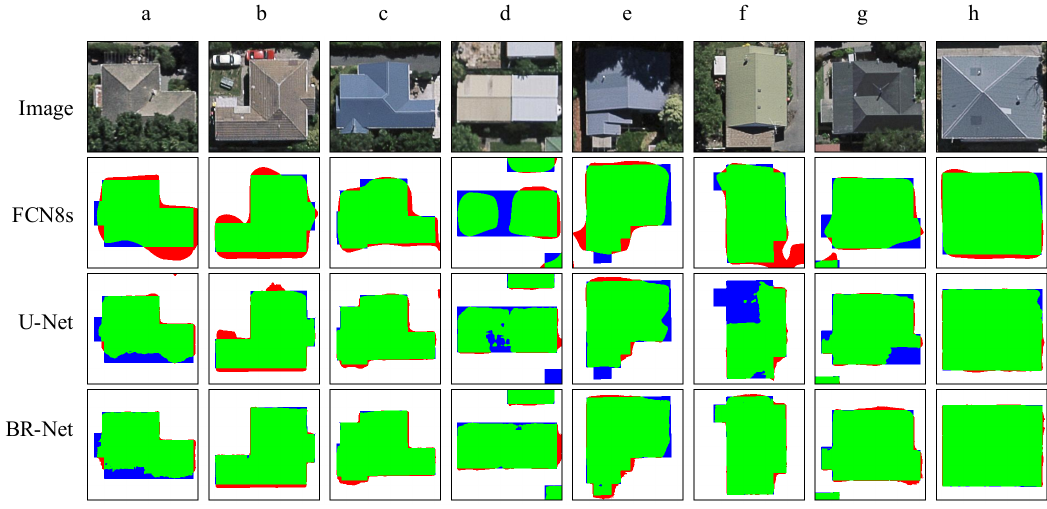
Figure 8. Representative results of single-building-level segmentation by FCN8s, U-Net, and BR-Net. The green, red, blue, and white channels in the results represent true positive, false positive, false negative, and true negative predictions,